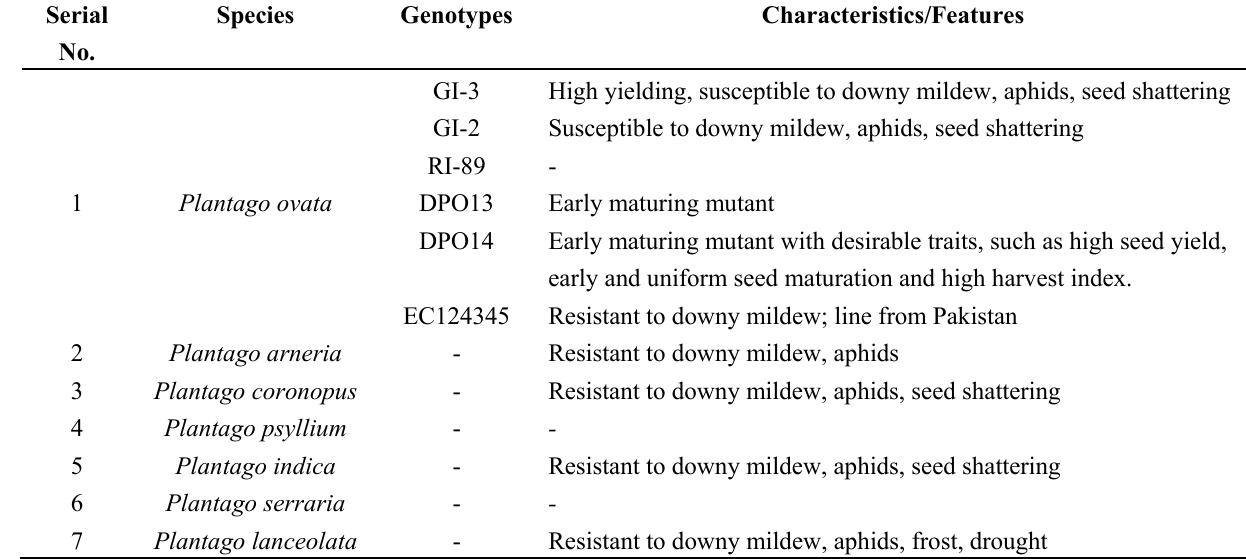
Table 1. List of Plantago